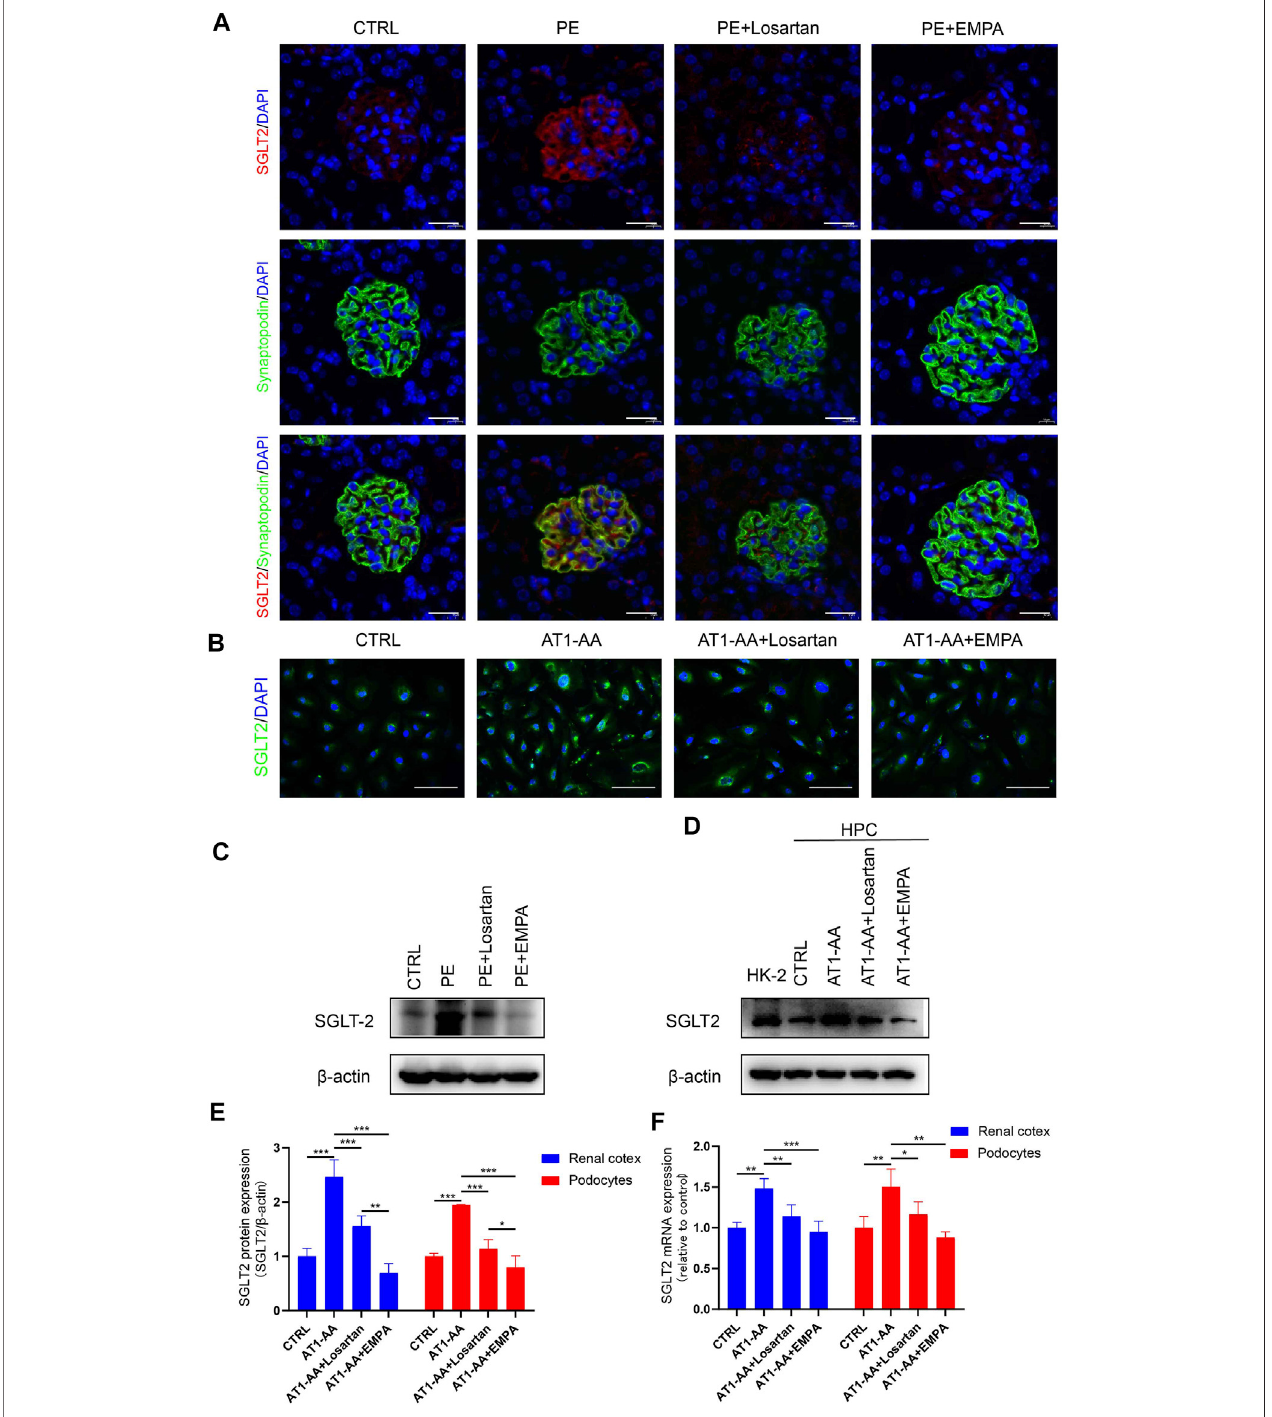
FIGURE 4 | SGLT2 is expressed in podocytes and upregulated by AT1-AA induction in vivo and in vitro . (A) Representative fl uorescence pictures of SGLT2 (red) and synaptopodin (green) in control and PE mouse glomeruli. Sections were counterstained for DNA (blue). Scale bar: 20 μ m. (B) Representative images of immuno fl uorescence staining for SGLT2 (green) in podocytes. Scale bar: 50 μ m. (C) Representative Western blots and (E) densitometric analysis of SGLT2 protein in renal cortex. (D) Representative Western blots and (E) densitometric analysis of SGLT2 protein in cultured human podocytes ( n = 3). (F) Podocytes SGLT2 and mouse renal cortex Sglt2 mRNA expression was evaluated by real-time qPCR analysis ( n = 3). Data are expressed as the mean ± SEM and were analyzed by ANOVA with LSD post hoc test. * p < 0.05, ** p < 0.01, *** p < 0.001.